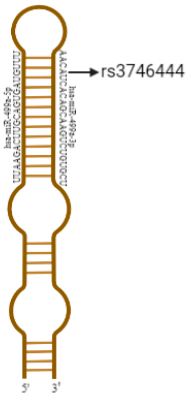
Figure 1. The structure of MIR499 and the maturity of sequence has-mir-499-3p representing all SNPs.